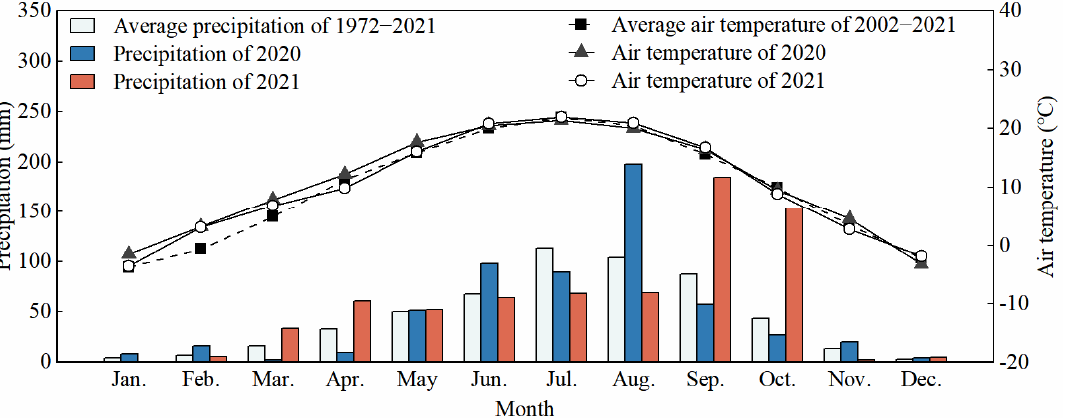
Figure 1. Monthly average temperature and precipitation in 2020, 2021, and multi-year (1972–2021).